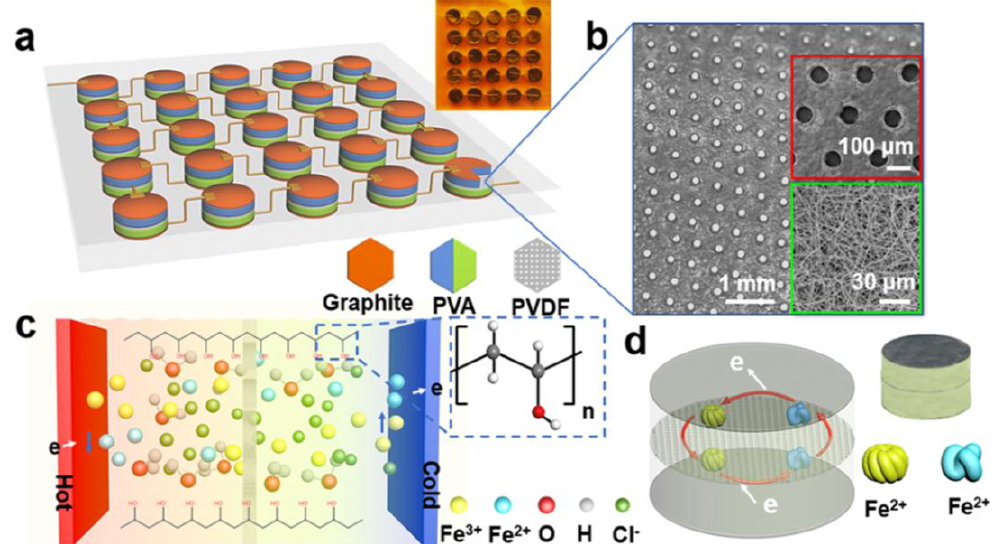
Figure 11. Thermocell working principle. ( a ) Integrated gel-based thermocell. The PVA gel was sandwiched between two flexible substrates (polyimide, PI), the porous PVDF diaphragm is inserted into the two gels, and the device is bridged by a tandem structure. The top right inset is a photograph of the integrated device (scale bar: 10 mm). ( b ) SEM photograph of the porous PVDF diaphragm. ( c ) Schematic representation of the partial contribution of the thermal potential in a complex system containing the structures of iron ions, ferrous ions, chloride ions, hydrogen ions, water molecules, and polyvinyl alcohol molecules. ( d ) Schematic diagram of the operating mecha- nism of a single thermoelectric gel and a physical photograph of the individual gel (scale bar: 10 mm). (Reproduced with permission from [118]. Copyright 2021 American Chemical Society).